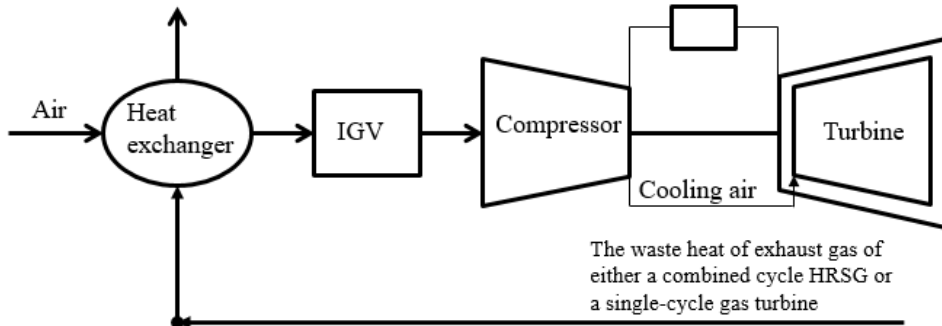
Figure 2. Diagram of an inlet air heating system of a gas turbine.